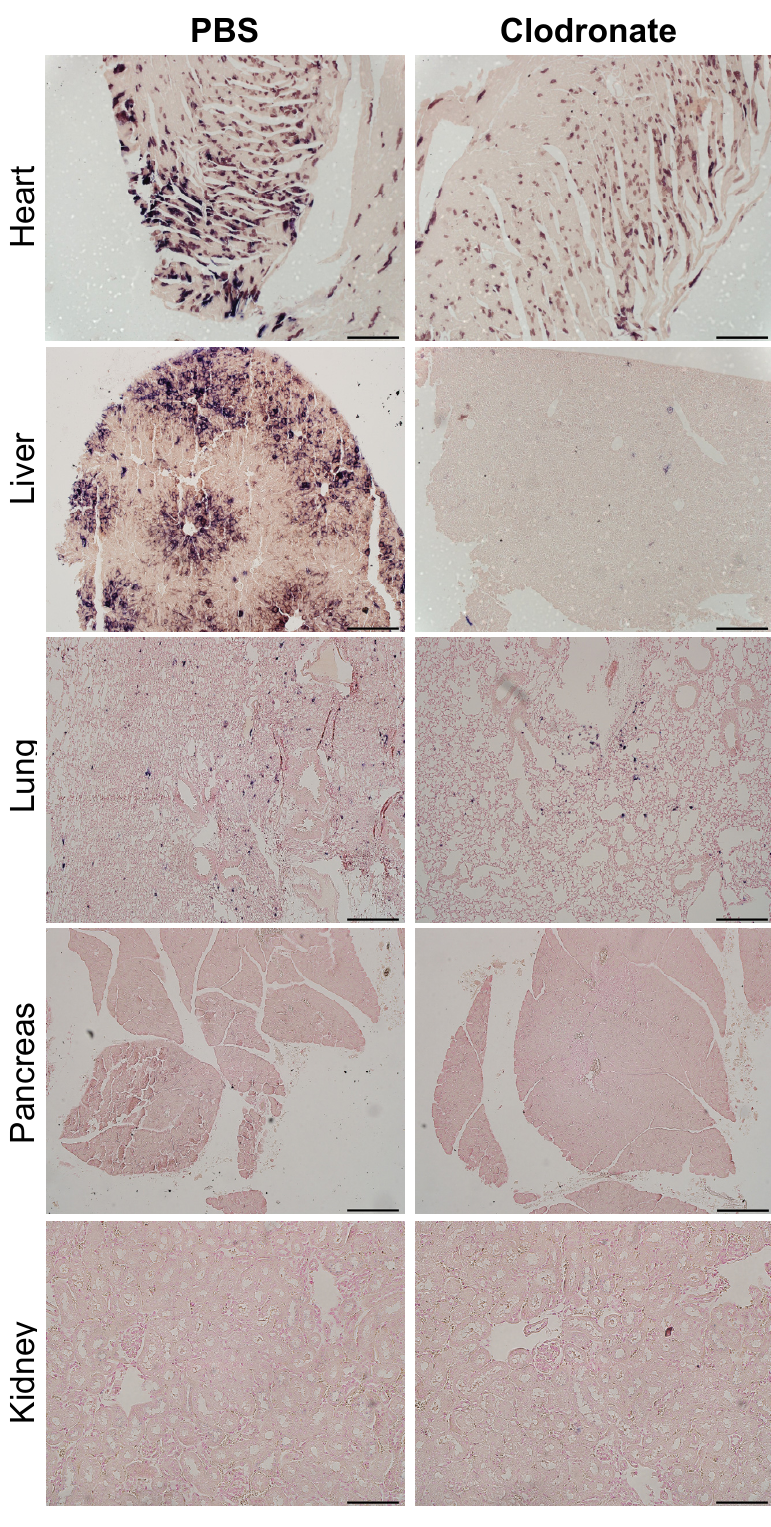
Figure 6. Representative tissue sections of the heart, liver, lung, and pancreas from clodronate-treated and control mice (PBS). Both groups were administered 1 × 10 11 vg of AAV vector expressing human placental alkaline phosphatase (hPLAP) via tail vein injection and euthanized 28 days later. Tissues were formalin fixed, paraffin embedded, and stained for hPLAP expression. Images were taken at 10× magnification for all tissues except the pancreas, which was imaged at 4×. 4× scale bar = 200 μ M, 10× scale bar = 100 μ M